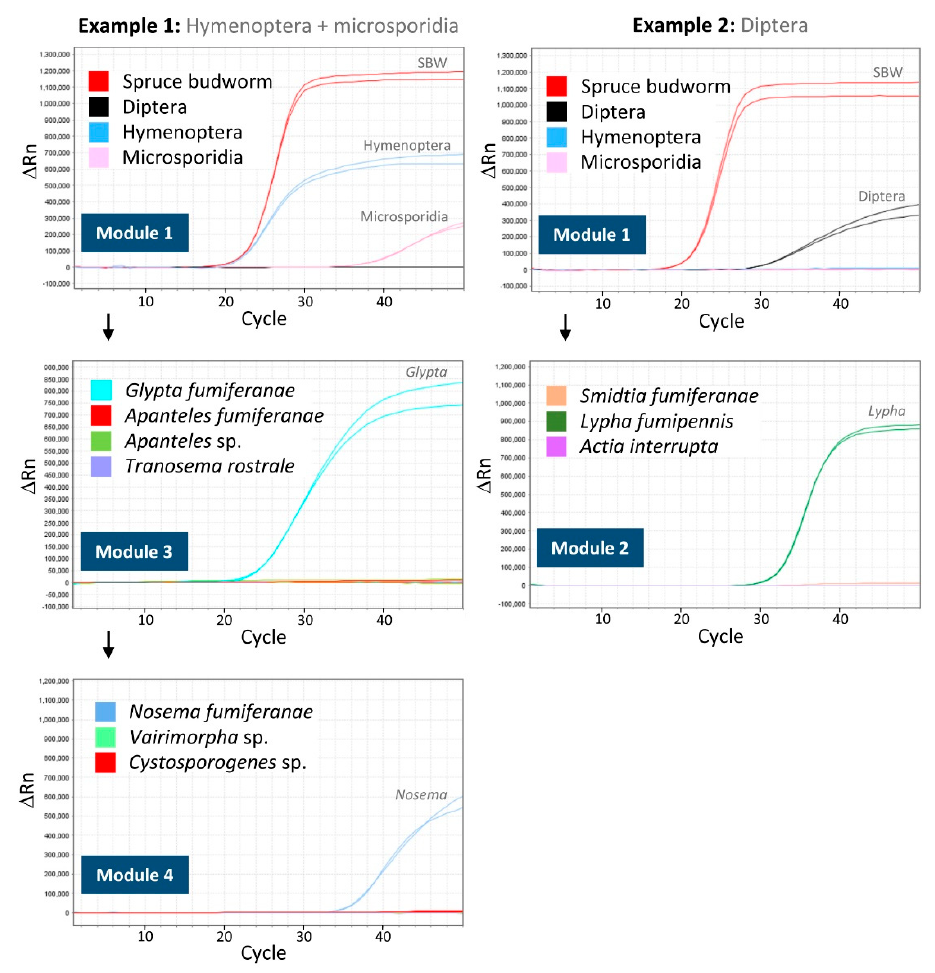
Figure 3. Examples of qPCR-TaqMan ® amplification curves (two technical replicates) obtained when conducting analyses using the molecular sorting tool. The first example, on the left, is for a spruce budworm sample that yields positive amplifications for both hymenopteran and microsporidian DNA in Module 1 (and for the spruce budworm; top panel). Then, the DNA sample is further processed through Module 3 to identify the hymenoteran parasitoid (middle panel; Glypta fumiferanae ; only the results of assay 4-plex 4 are shown here as assays 4-plex 5 and 3-plex 6 yielded no amplification) and through Module 4 to identify the microsporidian pathogen (bottom panel; Nosema fumiferanae ). The second example, on the right, is for a spruce budworm sample that yields a positive amplification for dipteran DNA in Module 1 (top panel). Then, the DNA sample is further processed through Module 2 to identify the dipteran parasitoid (bottom panel; Lypha fumipennis ; only the results of assay 3-plex 3 are shown here as assay 3-plex 2 yielded no amplification). The DNA samples used to generate the data presented here are from the field survey whose results are presented in Figure